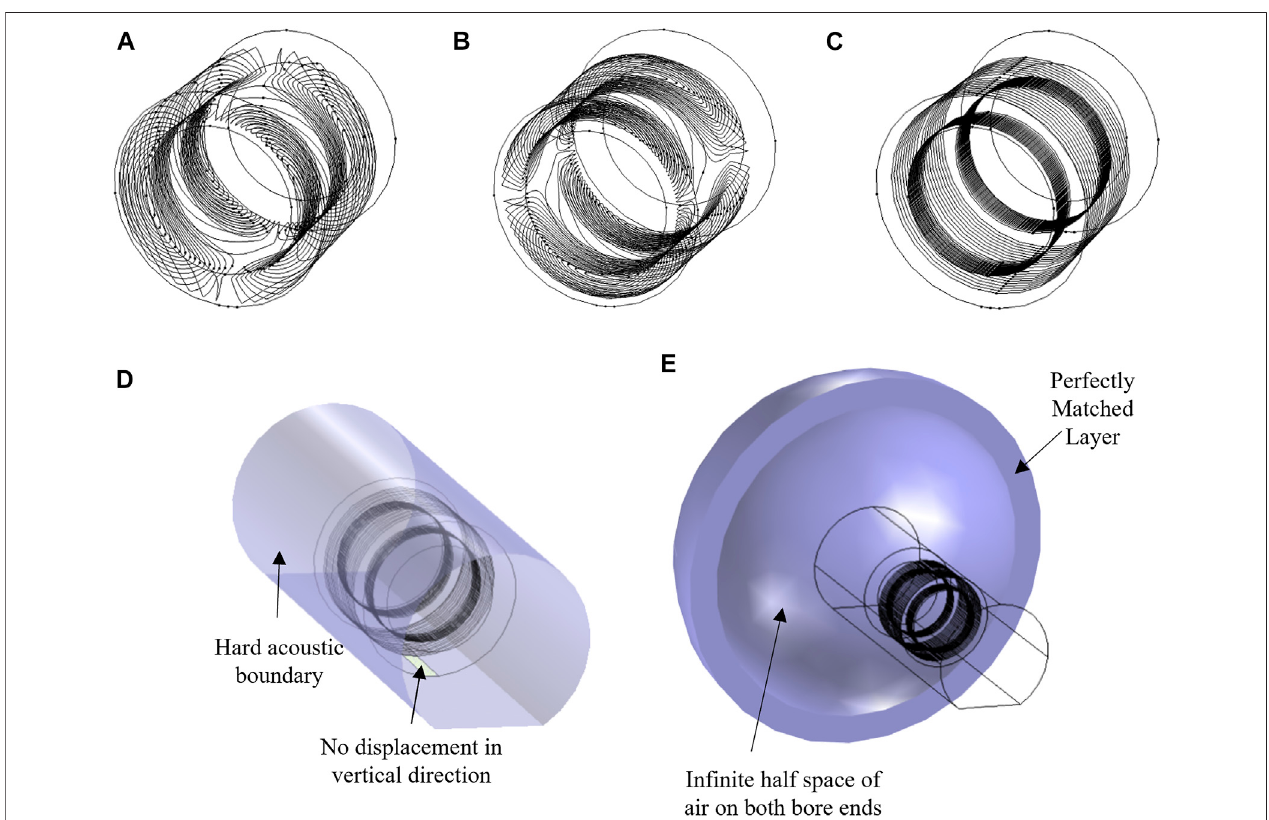
FIGURE 2 | Simulation model. (A) X-, (B) Y-, and (C) Z-axis gradient coils. (D,E) Applied boundary conditions.